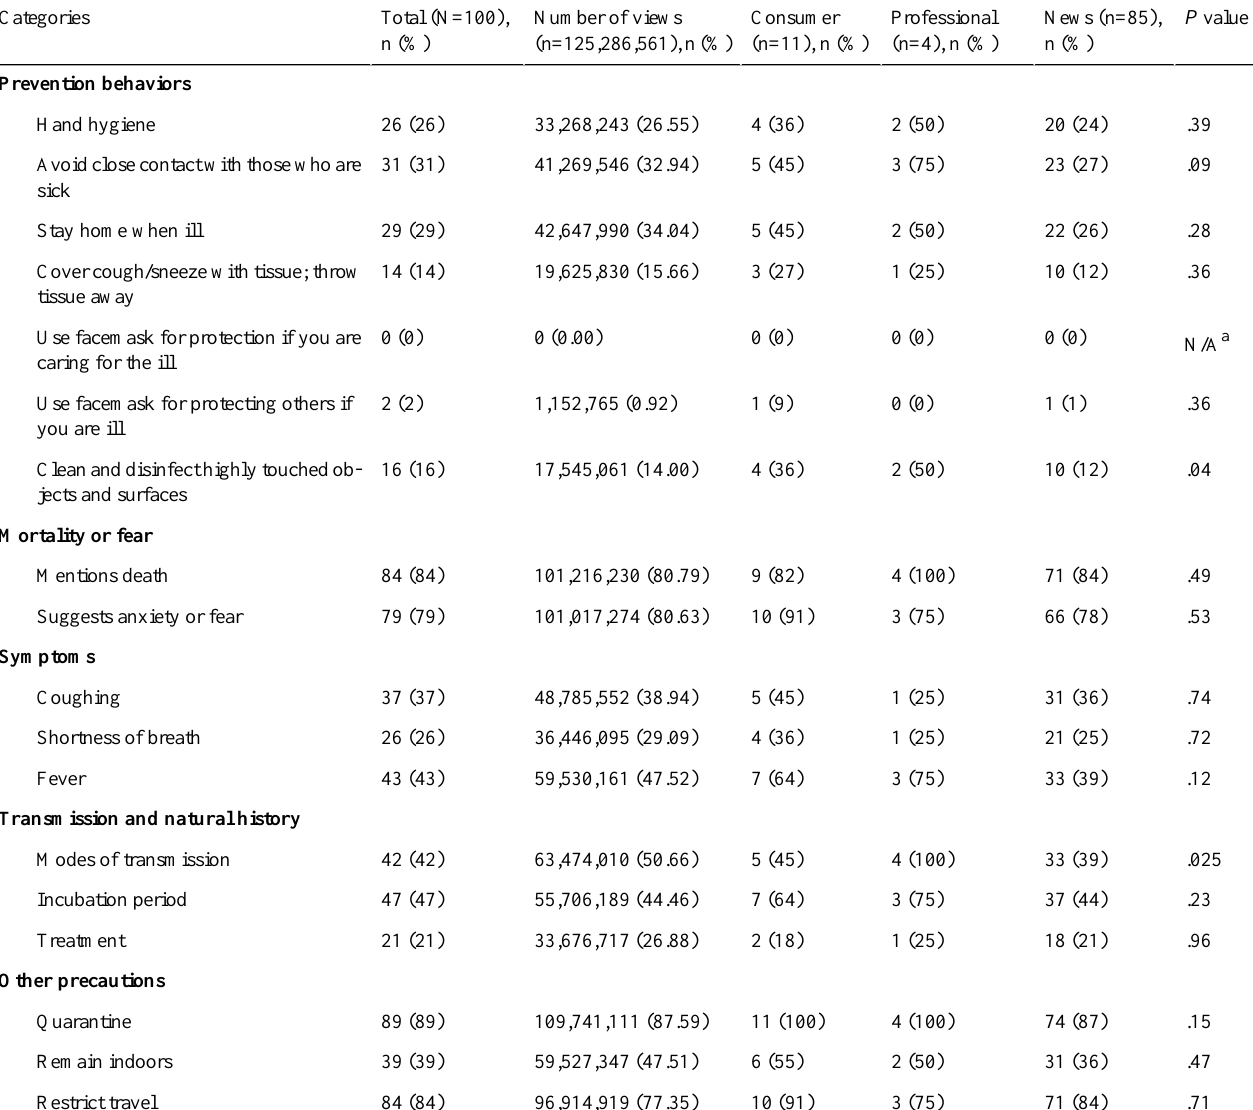
Table 1. Description of content covered in 100 widely viewed YouTube videos about coronavirus disease 2019, January 2020.